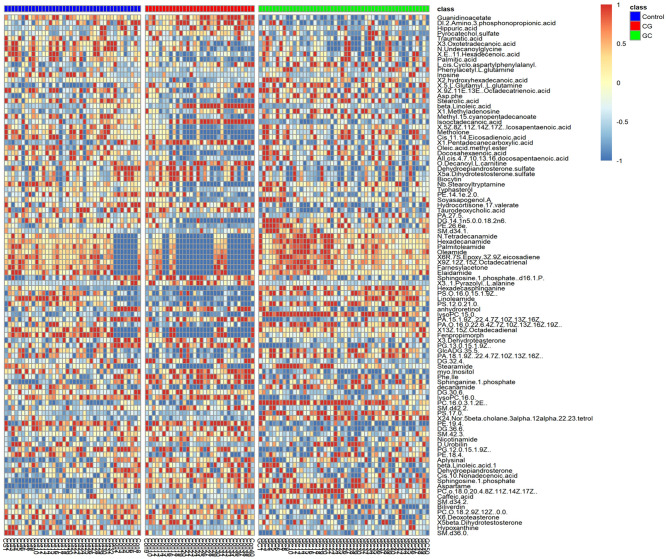
Heat map of the 100 significantly differential metabolites in the serum in the control (purple), CG (red), and GC (green) groups. Metabolites were included based on VIP > 1, FC > 1.5 or FC < 2/3, and p < 0.05. The colors from blue to red indicate the relative contents of the metabolites in the three groups.